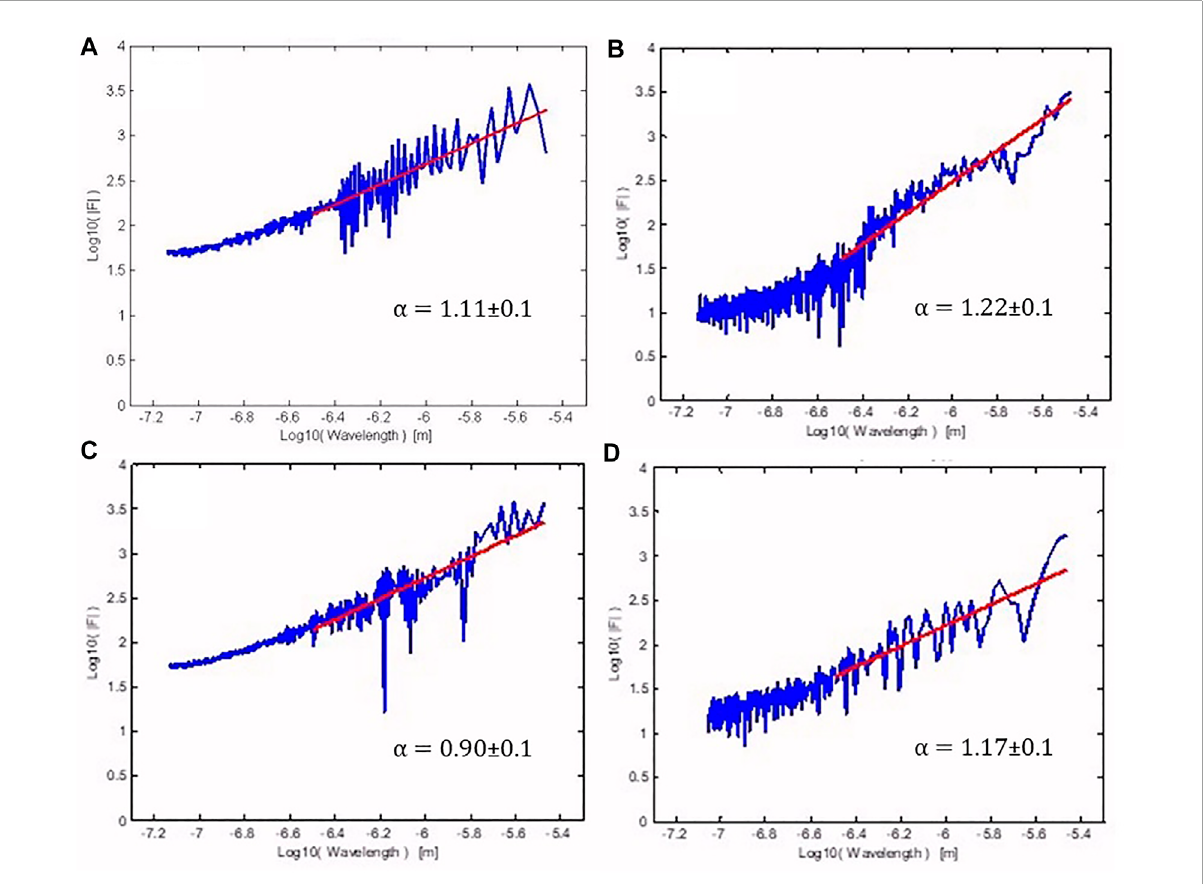
FIGURE 10 FFT spectra, Log 10 | F | vs. Log 10 λ [m], of different fabrics measured along transversal lines for (A) untreated, (B) sprayed, (C) plasma-treated and sprayed, and (D) plasma-treated-only samples. The power law fits to the longer scale regions are also shown, and the corresponding values of α are reported in